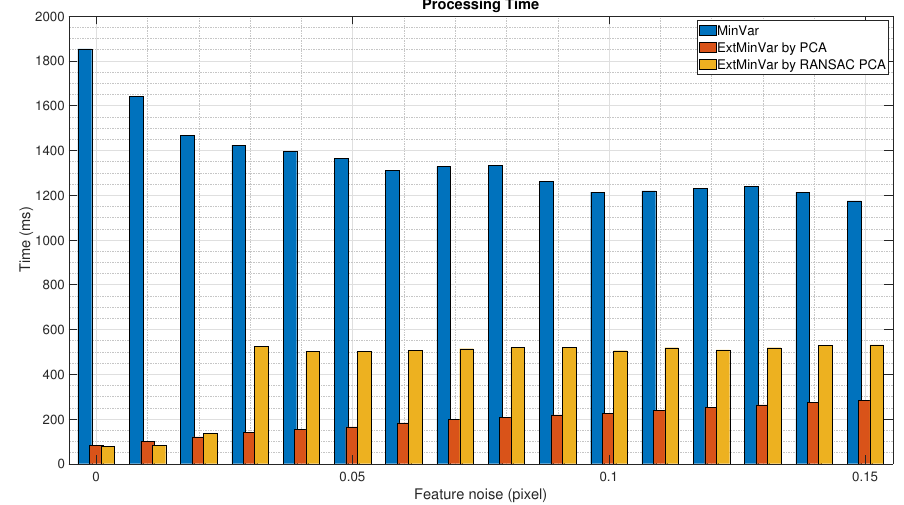
Figure 11. Experimental results using synthetic data with feature noise [0–0.15 pixel]: Processing time during